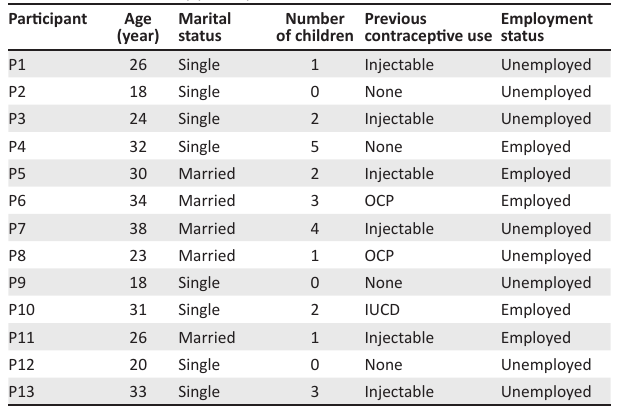
TABLE 1: Profile of study participants.